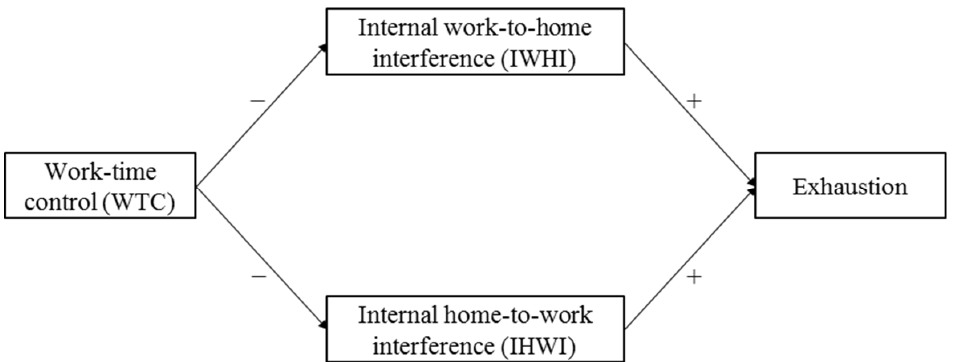
Figure 1. Hypothesized relationships between work-time control (WTC), internal work-to-home interference (IWHI), internal home-to-work interference (IHWI), and exhaustion. − = negative effect; + = positive effect.